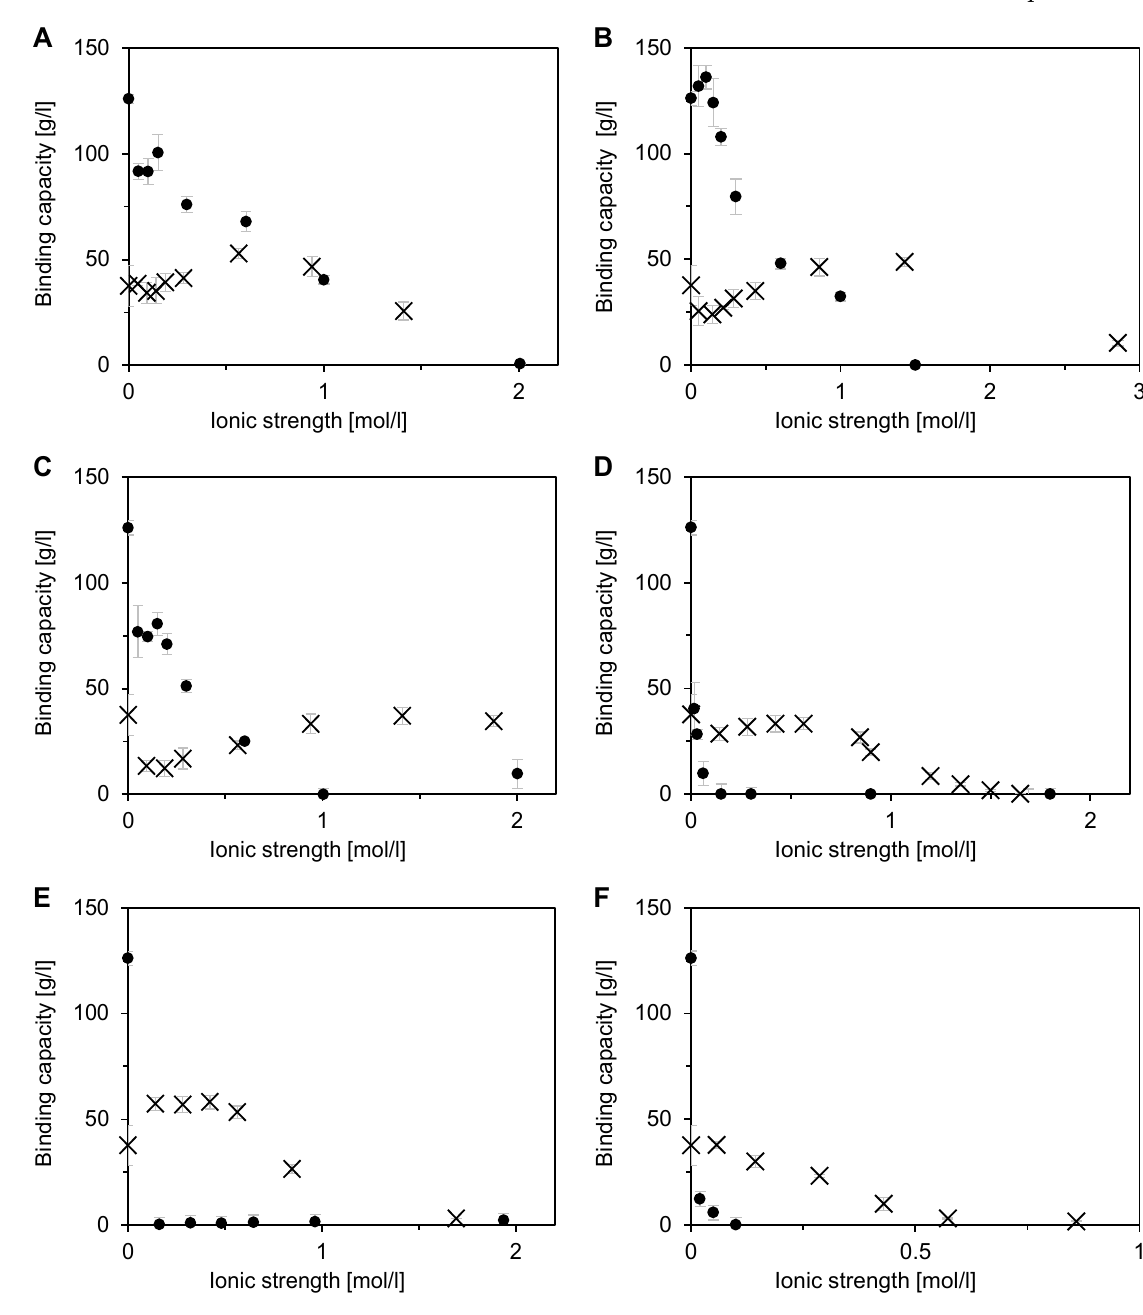
Figure 5. Influence of salt type and ionic strength on single-component adsorption of BSA ( ● ) and DNA ( 🞨 ) on Sartobind STIC using a micromembrane module with centrifuge-forced flow at a pH of 8. ( A ) NaSCN, ( B ) NaCl, ( C ) NH 4 Cl, ( D ) (NH 4 ) 2 SO 4 , ( E ) Na 2 SO 4 , and ( F ) NaH 2 PO 4 /Na 2 HPO 4 . Error bars represent standard deviations.